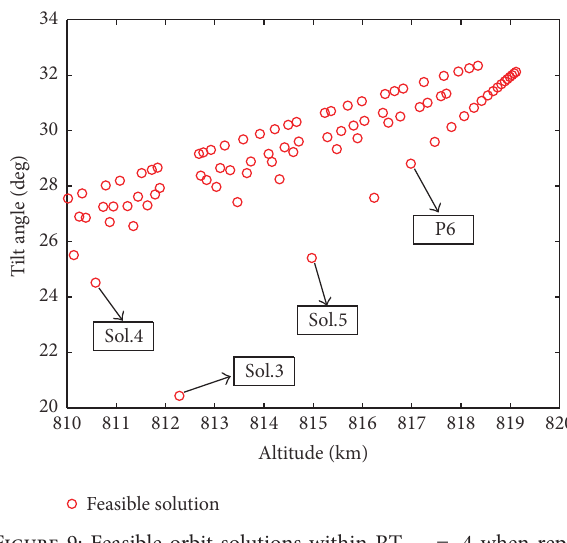
Figure 9: Feasible orbit solutions within RT des = 4 when repeat cycle 𝐷 max = 100 .